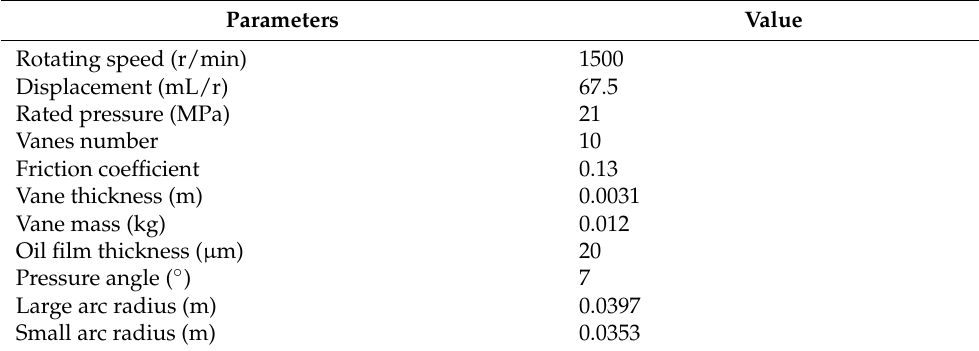
Table 1. Structural and simulation parameters.